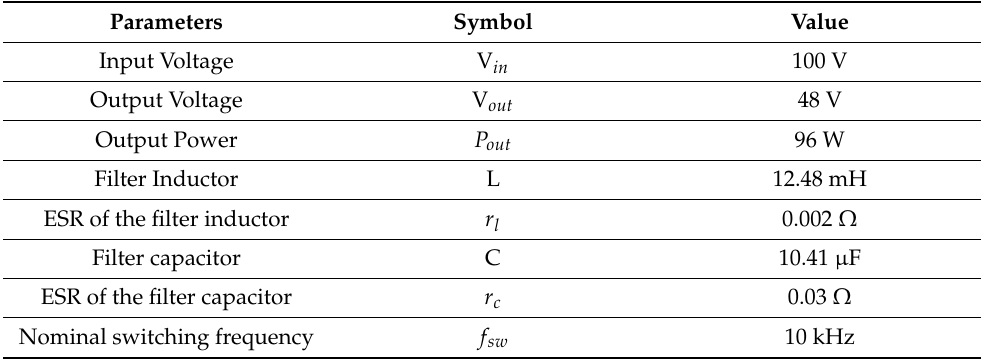
Table 2. Nominal parameters of buck